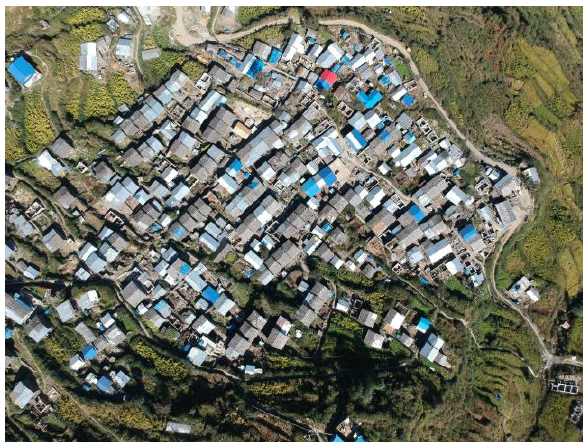
Figure 1. Aerial view of Gatlang (Álvaro Rodríguez. UEM student).